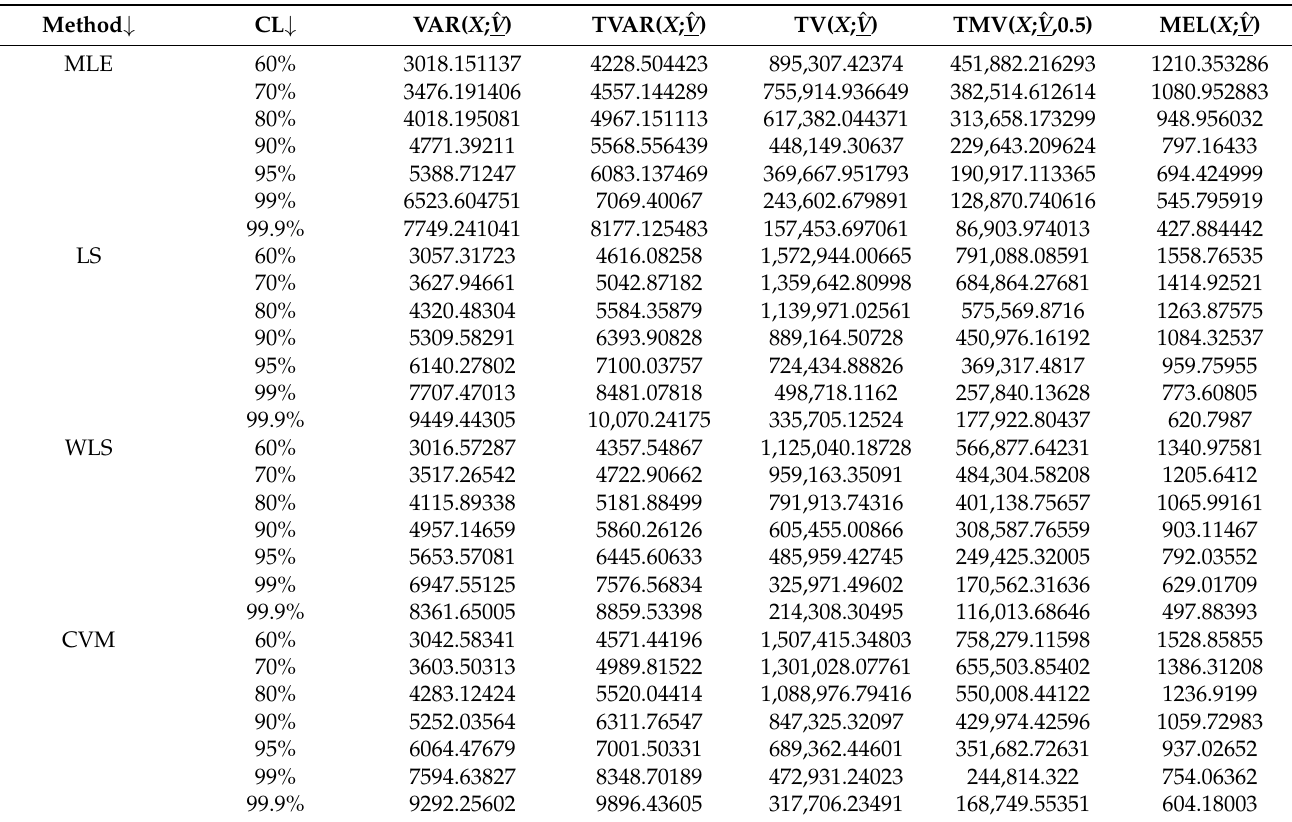
Table 6. The KRIs for the C model under insurance claims